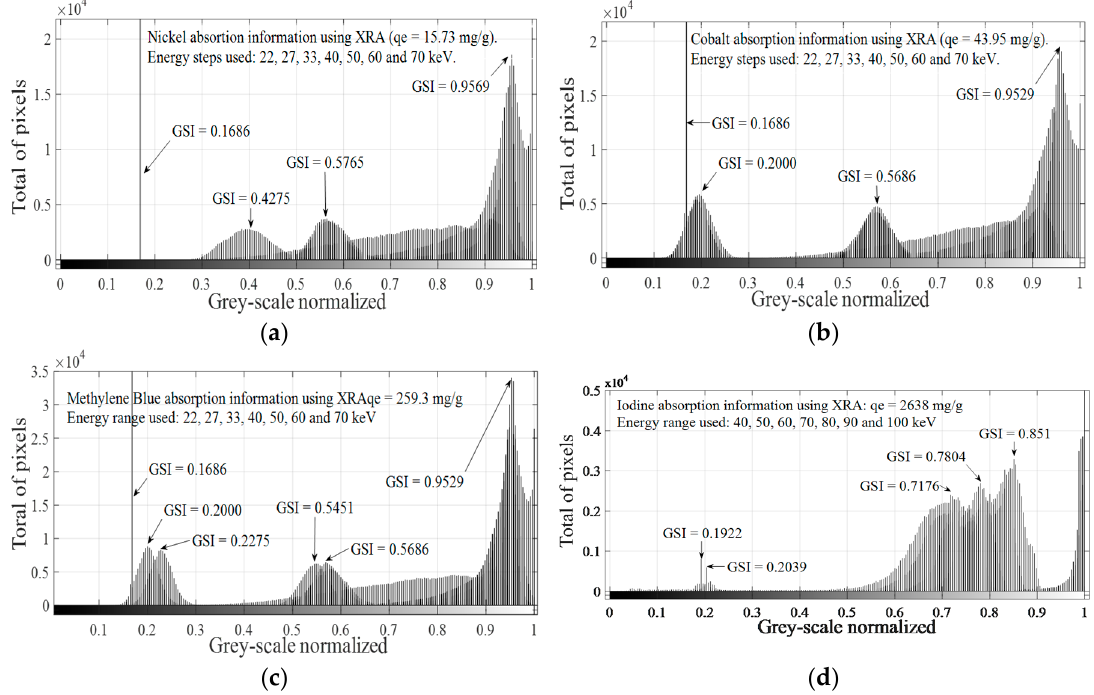
Figure 7. Histogram combined strategy using XRA data for: nickel ( a ); cobalt ( b ); MB ( c ); and Iodine ( d ). In Figure 7, it is possible to observe different patterns for each analyzed molecule or ion. Nickel presents distinctive peaks at GSI = 0.1686, GSI = 0.4275, GSI = 0.5765 and GSI = 0.9569. Cobalt shows typical peaks at GSI = 0.1686, GSI = 0.2000, GSI = 0.5686 and GSI = 0.9529. MB shows typical peaks at GSI = 0.1686, GSI = 0.2000, GSI = 0.2275, GSI = 0.5451, GSI = 0.5686 and GSI = 0.9529. For MB, four GSI values matched with GSI values of cobalt ( GSI = 0.1686, GSI = 0.2000, GSI = 0.5686 and GSI = 0.9529), but with different total pixel values, and only one matched with nickel ( GSI = 0.1686). The GSI peak at 0.1686 is a very narrow peak with a very high maximum total pixel value of 115,000. Iodine depicts an absorption signature slightly different in comparison with nickel, cobalt and MB. In this case, higher GSI values are found for each irradiation energy, which is consistent with iodine high atomic number and larger q e values found for its adsorption onto GAC1. For this molecule, characteristic peaks are found at GSI = 0.1922, GSI = 0.2039, GSI = 0.7176, GSI = 0.7804 and GSI = 0.8510. Figure 7 shows different patterns for different adsorbed molecule or ions onto GAC1 by the XRA method. Typical GSI values were found for each analyzed ion or molecule in the used energy range, which can be used as a digital signature for each adsorbed molecule or ion using the histograms combination strategy. For instance, if more than four peaks are found in the histogram combination figure of GSI for MB and Co, GSI peaks at 0.2275 and at 0.5451 can be used to prove the presence of MB in a solution instead of Co. For Ni and I 2 , differentiation is easier since the pattern of their combined GSI peaks is unique and